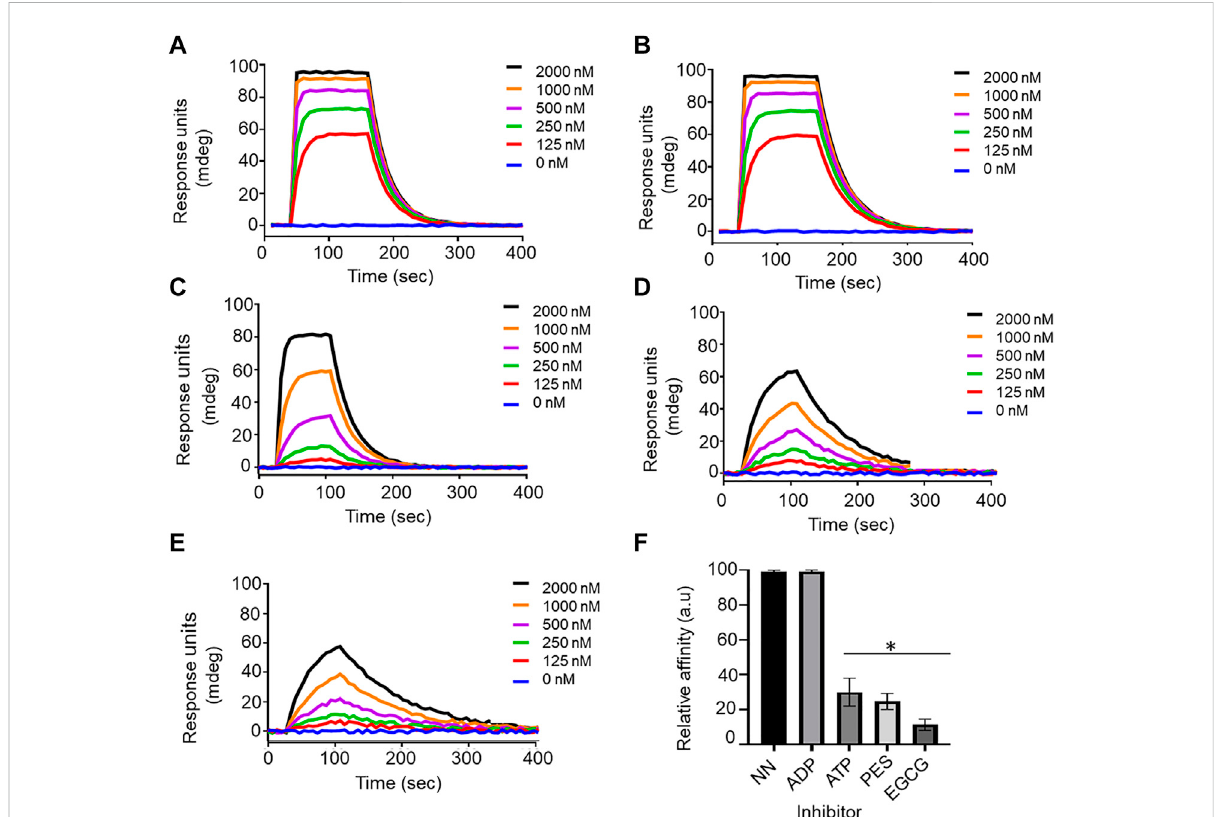
FIGURE 8 Con fi rmation of the inhibitory function of PES on PfHop-PfHsp70-1 association. Representative sensorgrams generated from data obtained in absence of nucleotide (A) , presence of ADP (B) , ATP (C) , and PES (D) and EGCG (E) are shown. The relative af fi nities of the association of PfHop with PfHsp70-1intheabsence(NN)ofbothnucleotidesandinhibitorscomparedtointeractioninthepresenceofnucleotidesandinhibitorsareshownin (F) . Standard errors represent three independent assays conducted in triplicates using independent protein batches. A student t-test was used for statistical validation and statistically signi fi cant differences relative to data obtained in the absence of nucleotide state (NN) are indicated by asterisks above the bar graphs ( p < 0.001*).